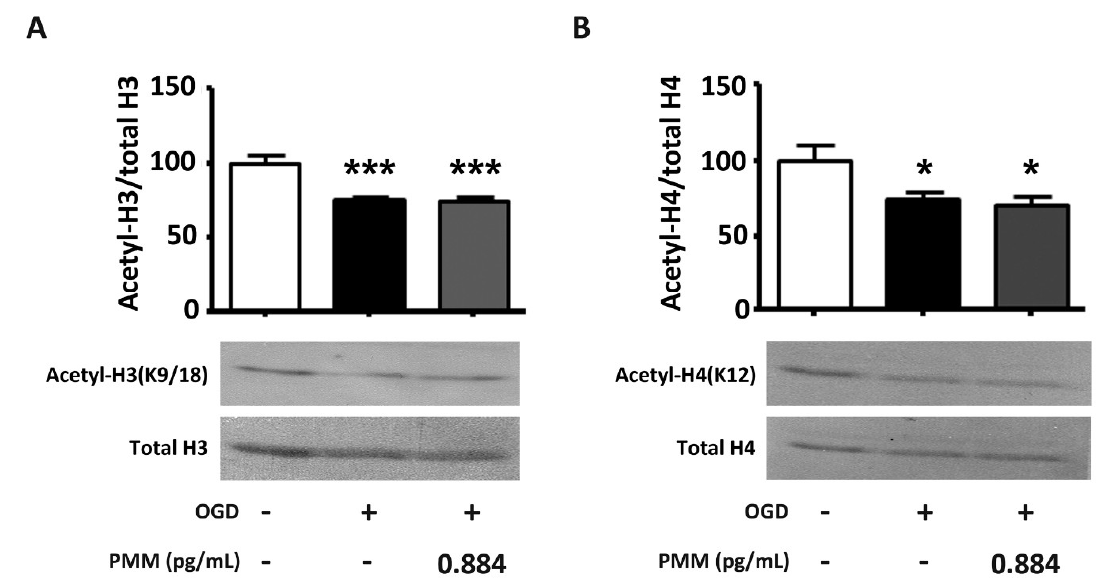
Figure 4. Pre-treatment with PMM does not modulate the acetylation of histones H3 and H4 in cortical neurons subjected to OGD. WB of acetylation levels of H3 ( A ) and H4 ( B ) in cortical neurons exposed to OGD. Cells were pre-treated with the PMM at DIV 7. At DIV 11, cells were exposed to 3 h of OGD and then maintained in recovery medium for 2 h. The mixture was renewed at every change of media. The WB assay was performed at the end of the 2 h of recovery. The lowest neuroprotective dose of the PMM was used (EGCG 0.10 nM; quercetin 0.11 nM; LA 0.16 nM; resveratrol 0.05 nM; vitamin C 0.89 nM; vitamin E 0.06 nM; vitamin B6 0.02 nM; N-acetyl L-cysteine 0.15 nM). DMSO was used as a vehicle in control cells and neurons exposed to OGD. The acetylation levels of histones H3 and H4 did not return to control levels after treatment with the mixture. The bar graph represents the mean of three different experiments. * p <0.05 and *** p < 0.001 vs. OGD-treated cells (one-way ANOVA followed by Dunnett’s multiple comparison test).